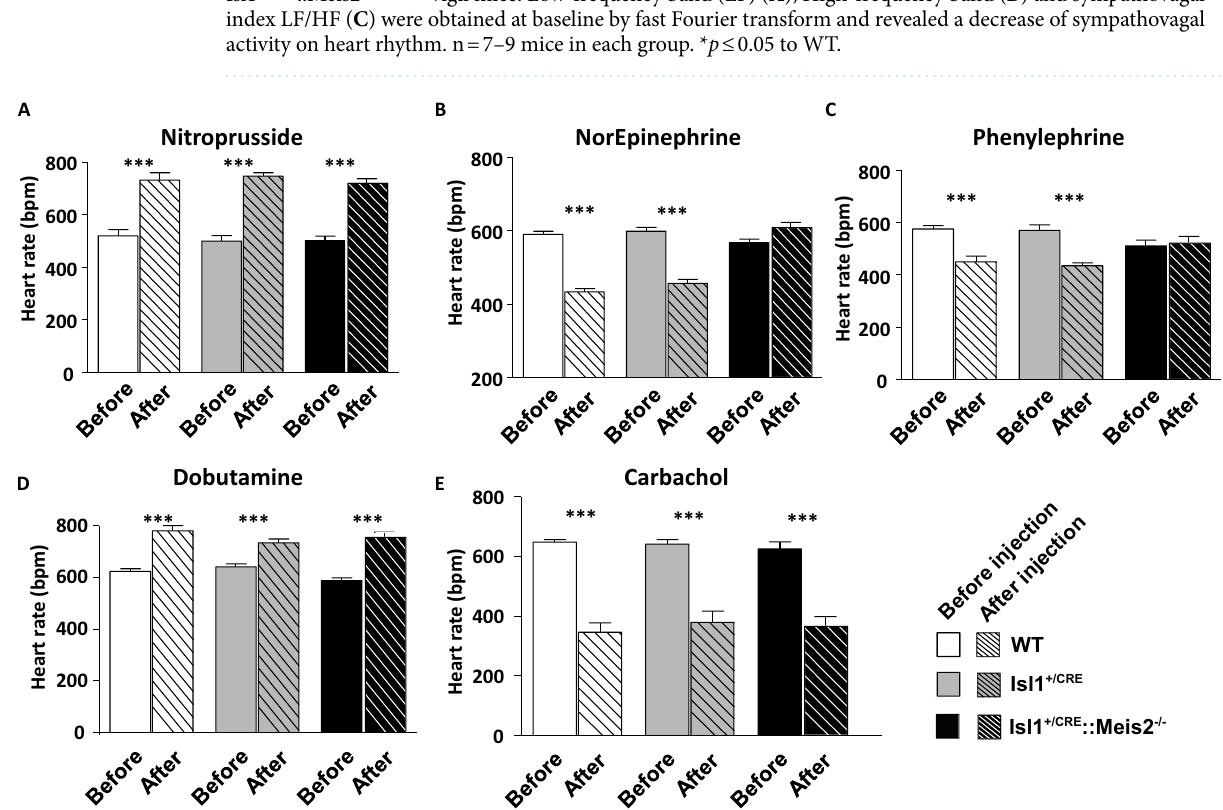
Figure 4. Blunted cardio-inhibitory reflex in Isl1 +/CRE ::Meis2 LoxP/LoxP mice. Graphs showing the heart rate adaptation after pharmacologically induced hemodynamic changes in WT, Isl1 +/CRE and Isl1 +/CRE ::Meis2 LoxP/LoxP vigil mice. Heart rate analyses were done before (plain bars) and after (dashed bars) injection of Nitroprusside ( A ), Norepinephrine ( B ), Phenylephrine ( C ), Dobutamine ( D ) and Carbachol ( E ). n = 5–7 mice in each group. *** p ≤ 0.001 vs before the